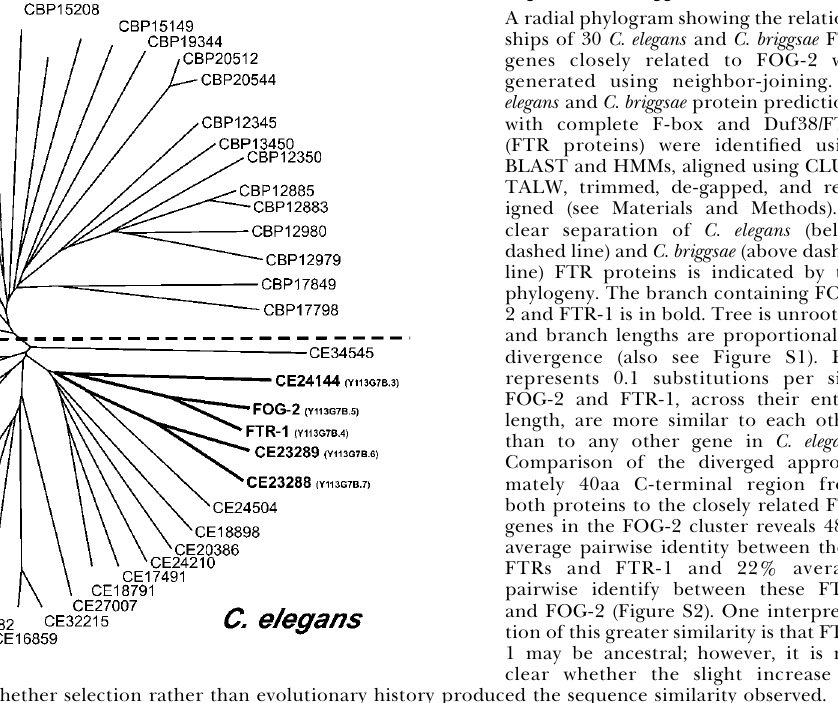
Figure 2. The FTR Gene Family in C. elegans and C. briggsae A radial phylogram showing the relation- ships of 30 C. elegans and C. briggsae